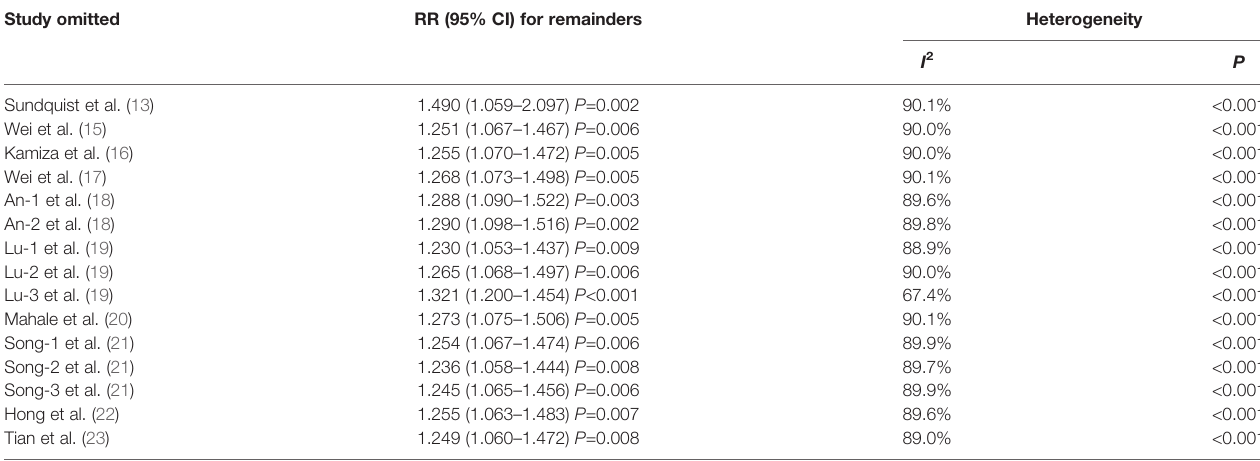
TABLE 2 | Sensitivity analysis after each study was excluded by turns in those studies reporting HBV and risk of gastric cancer.